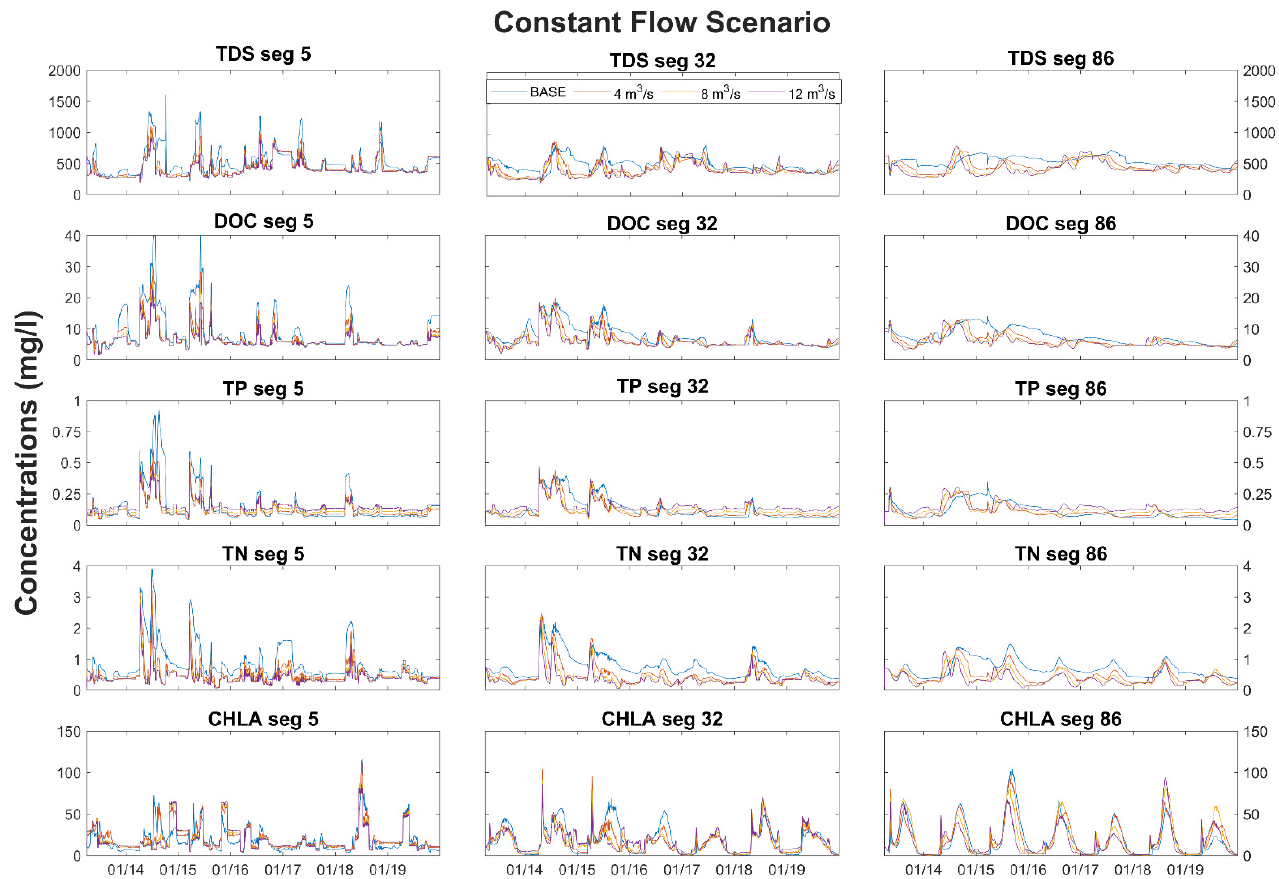
Figure 5. Output for five model-derived water quality constituents of interest at segments 5, 32 and 86 for the constant flow scenario. Scenario flow rates for the water transfers are 4, 8 and 12 m 3 /s.